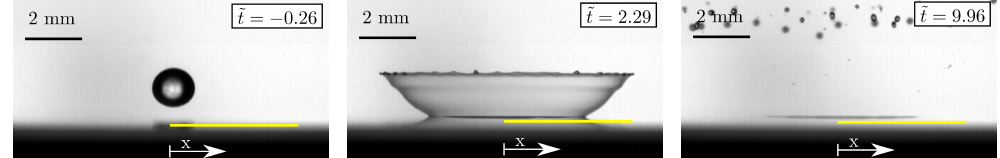
Figure 2. S10 drop impacting on a S10 film. Consecutive images from the experiment of a S10 drop impacting on a S10 film. The yellow line indicates the location of the film thickness measurements shown in Figure 3 whereat x represents the longitudinal coordinate of the CLS; Impact Parameters: U = 3.95 m/s, D = 1.55 mm, H f = 42 µ m.